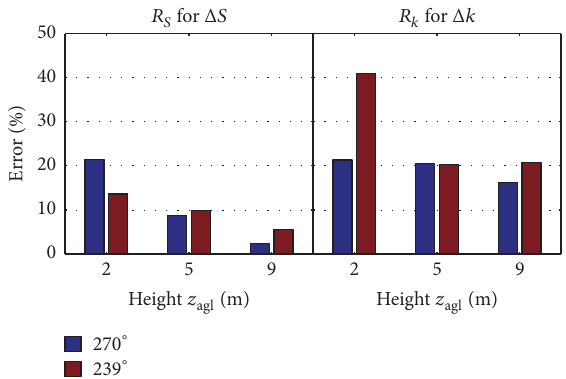
Figure 12: Simulation errors: 𝑅 𝑆 for speedup and 𝑅 𝑘 for TKE increase errors at different measurement locations. The errors ( 𝑅 𝑆 and 𝑅 𝑘 ) are averaged over the height for each location.